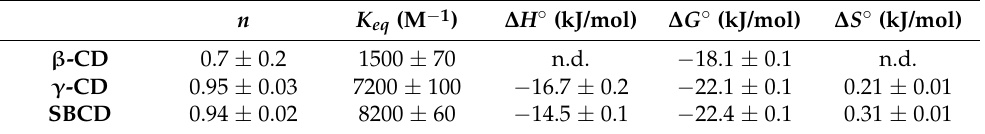
Figure 2. Isothermal titration calorimetry data obtained for the binding interaction of VTD with: ( a ) β − CD, ( b ) γ − CD, and ( c ) SBCD. The upper graphs show the variation of heat released upon injection of 10 µ L of each CD. The lower graphs correspond to the binding curve obtained from the integrated heat data. Conditions: [VTD] = 0.2 mM, [CD] = 4 mM, T = 298.2 K. Table 1. Stability constants ( K eq ), standard enthalpy changes ( ∆ H ◦ ), Gibbs’s binding energy ( ∆ G ◦ ), and entropy changes ( ∆ S ◦ ) for the formation of VTD complexes with three CD hosts ( γ -CD, SBCD, and β -CD) in tris buffer solution pH 6 at 298.2